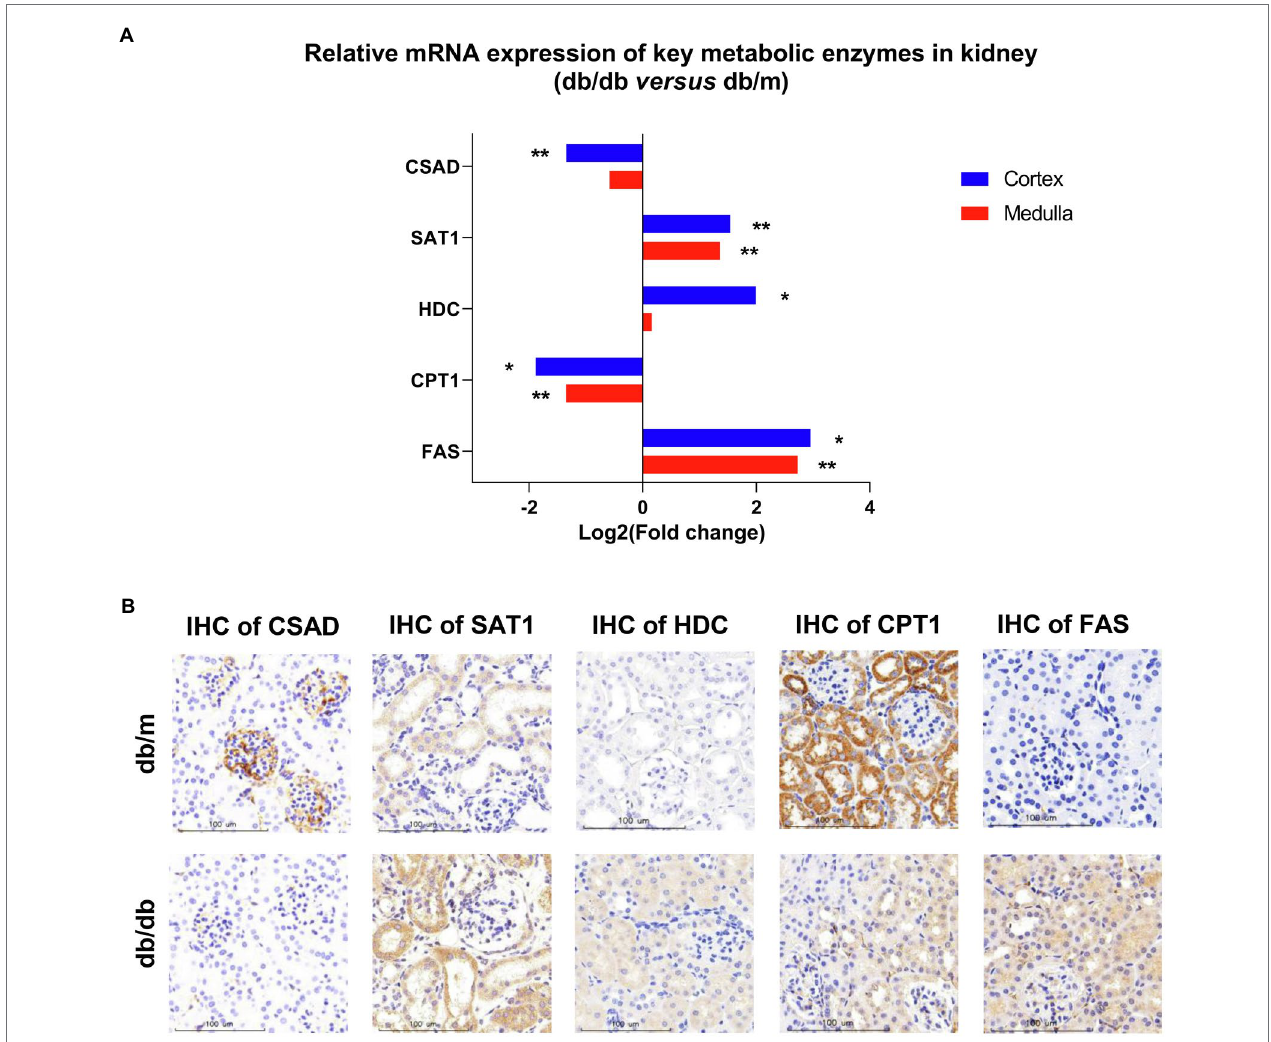
FIGURE 8 | The validation of real-time PCR and specific immunohistochemistry (IHC) for different rate-limiting enzymes in specific metabolic pathways between db/m ( n = 7) and db/db ( n = 6) mice kidneys. (A) Levels of mRNA expression in renal cortex and medulla according to real-time PCR are shown. The data using fold changes converted to logarithms of db/db vs. db/m mice. * p < 0.05; ** p < 0.01 ( t -test). (B) Representative IHC of rate-limiting enzymes including CSAD, SAT1, HDC, CPT1, and FAS in the kidneys between db/m and db/db mice are shown. bar = 100 μ